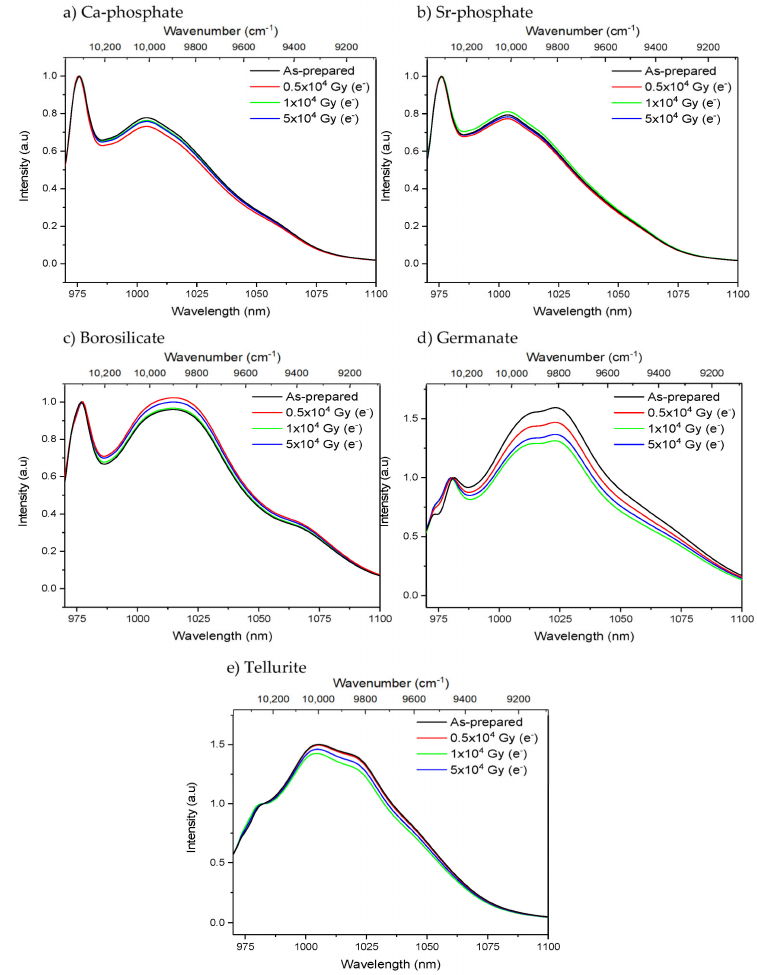
Figure 4. Normalized Yb 3+ emission bands of the Ca-phosphate ( a ), Sr-phosphate ( b ), borosilicate ( c ), germanate ( d ) and tellurite ( e ) glasses prior to and after electron irradiation. The spectra are normalized at the zero-line emission band. ( λ exc. = 963